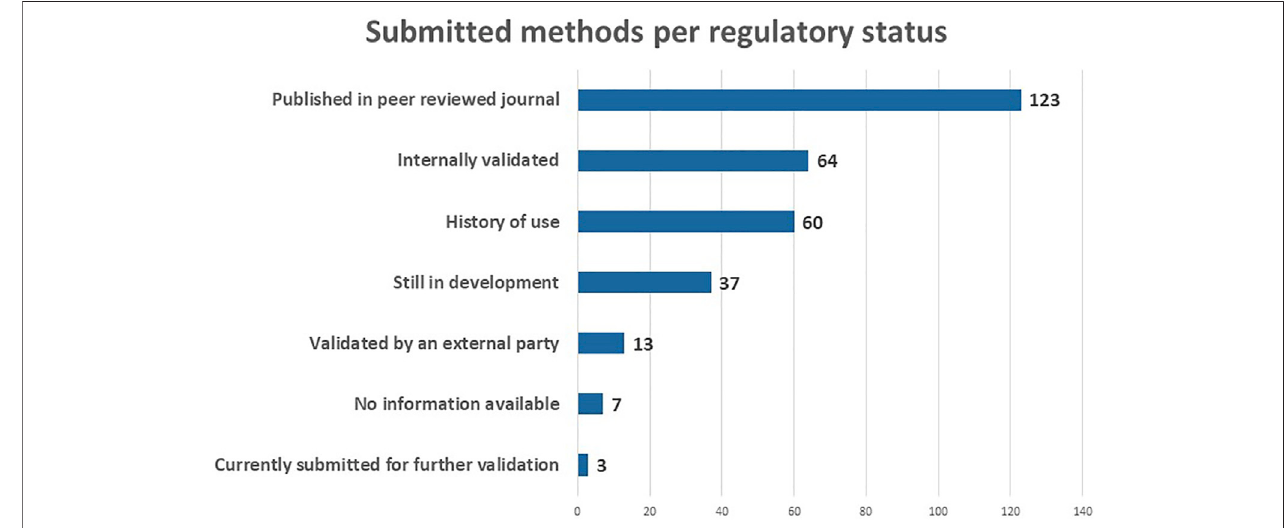
FIGURE 5 | Submitted methods per regulatory status in May